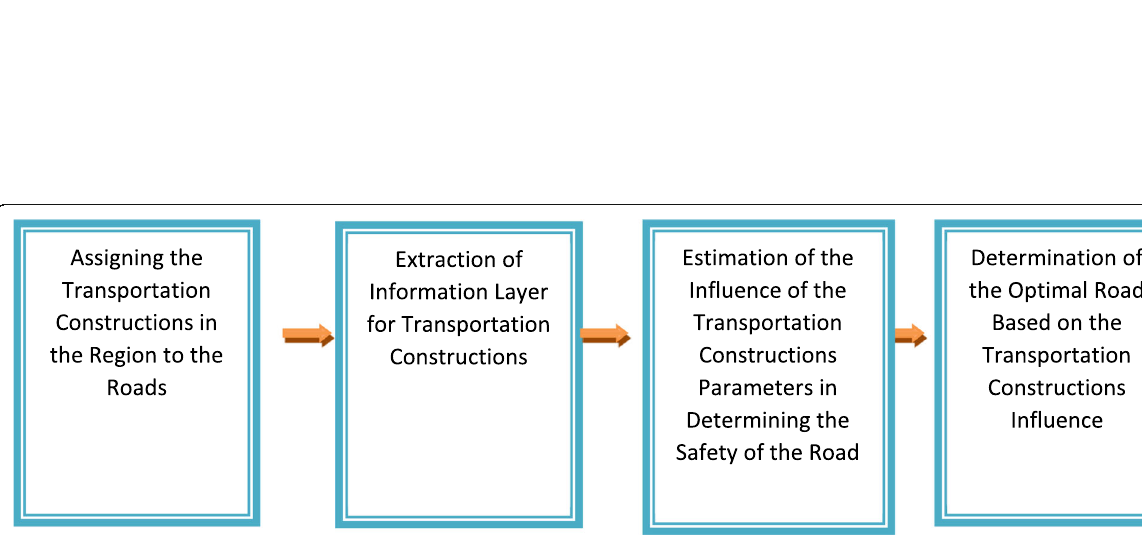
Fig. 6 Estimating transportation constructions index method and its optimal road determination